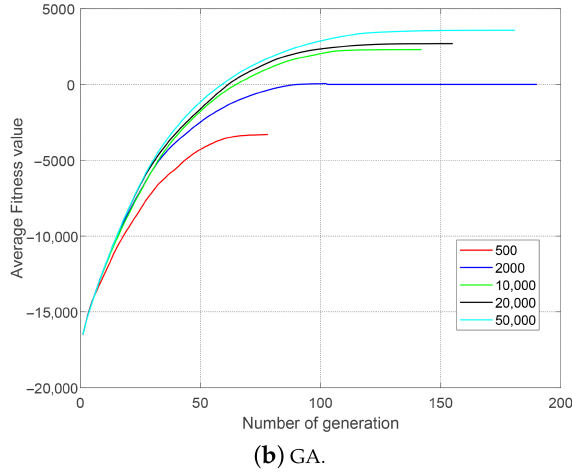
Figure 4. Trends of average fitness values of GA-AS and GA with different population sizes.